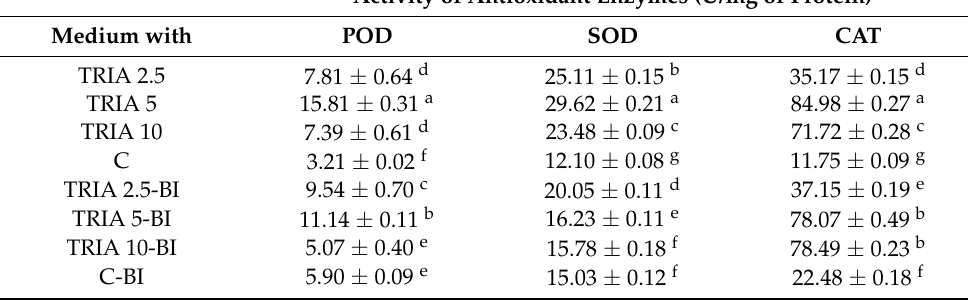
Table 1. Effect of triacontanol on the antioxidant enzyme activities in D. forrestii shoots cultured for five weeks on MS medium containing TRIA ( µ g/L) or TRIA and 0.5 mg/L BAP and 0.2 mg/L IAA (TRIA-BI). C-control medium without growth regulators, C-BI- control-medium with 0.5 mg/L BAP and 0.2 mg/L IAA. Activity of Antioxidant Enzymes (U/mg of Protein) Medium with POD SOD CAT TRIA 2.5 7.81 ± 0.64